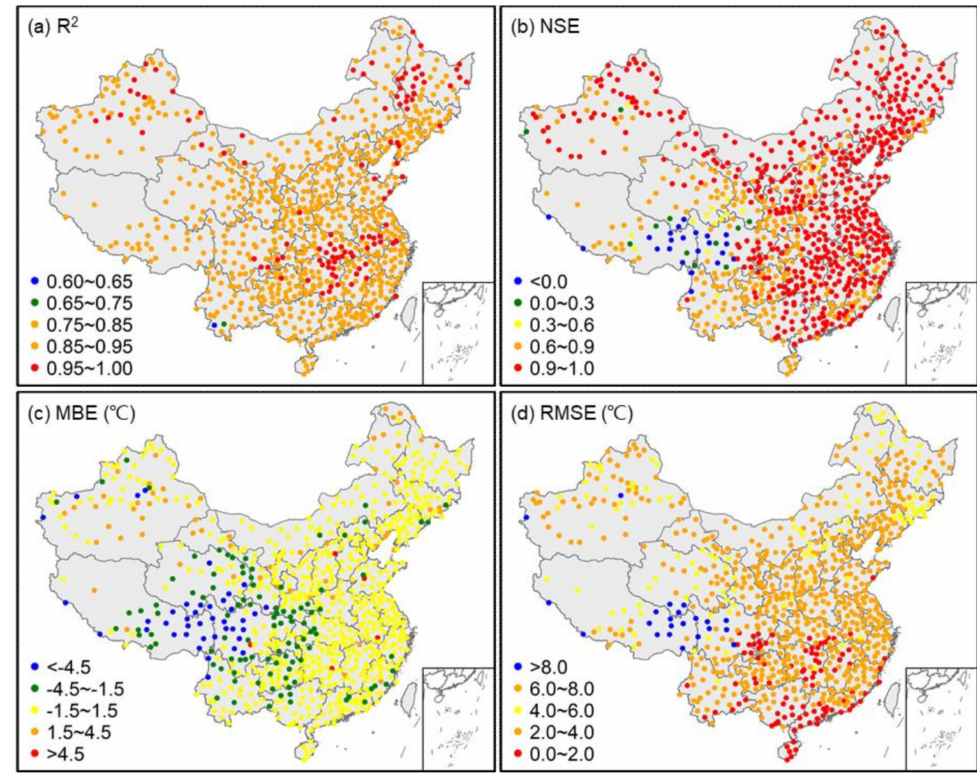
Figure 3. Statistical indices of the daily minimum T a from ERA5-Land against observed daily minimum TEM from CMCD (V3.0) at 822 national surface weather stations in China. ( a ) R 2 , coefficient of determination; ( b ) NSE , Nash–Sutcliffe efficiency coefficient; ( c ) MBE , mean bias error; ( d ) RMSE , root mean square